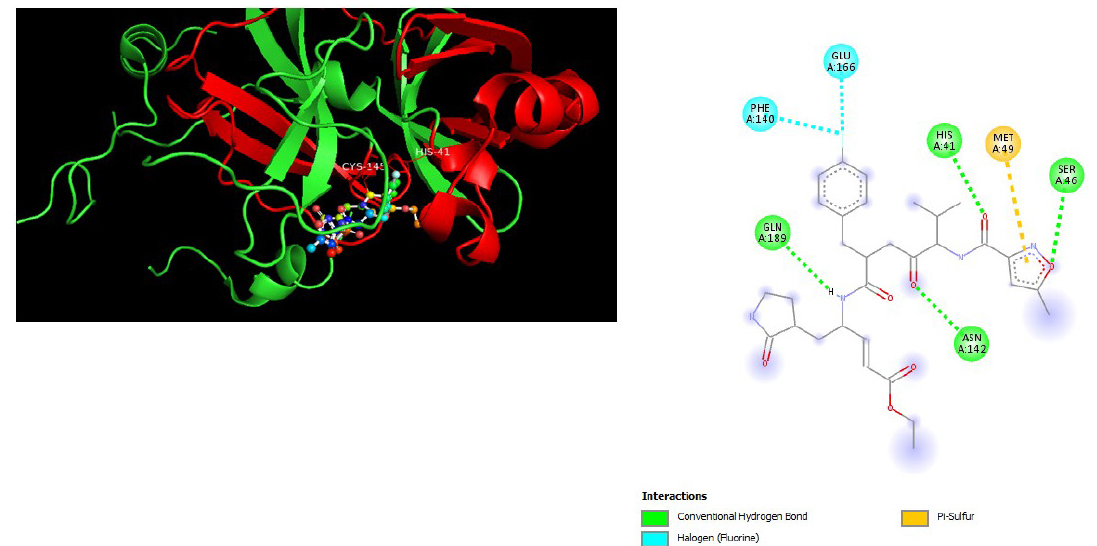
Figure 3. The co-crystallized ligand rupintrivir with its 2D and 3D